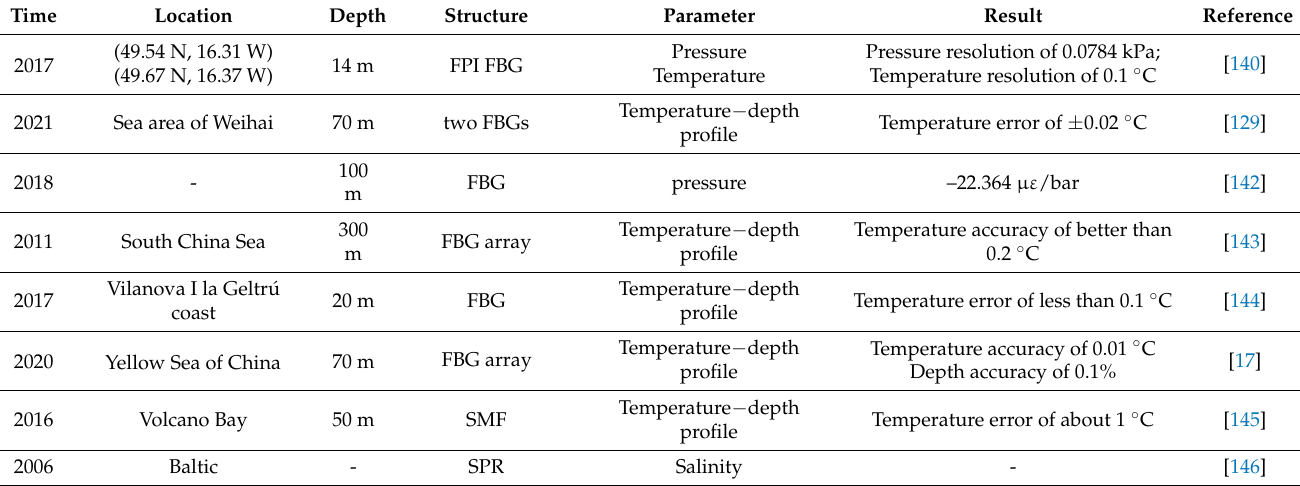
Table 2. OFSs applied in sea